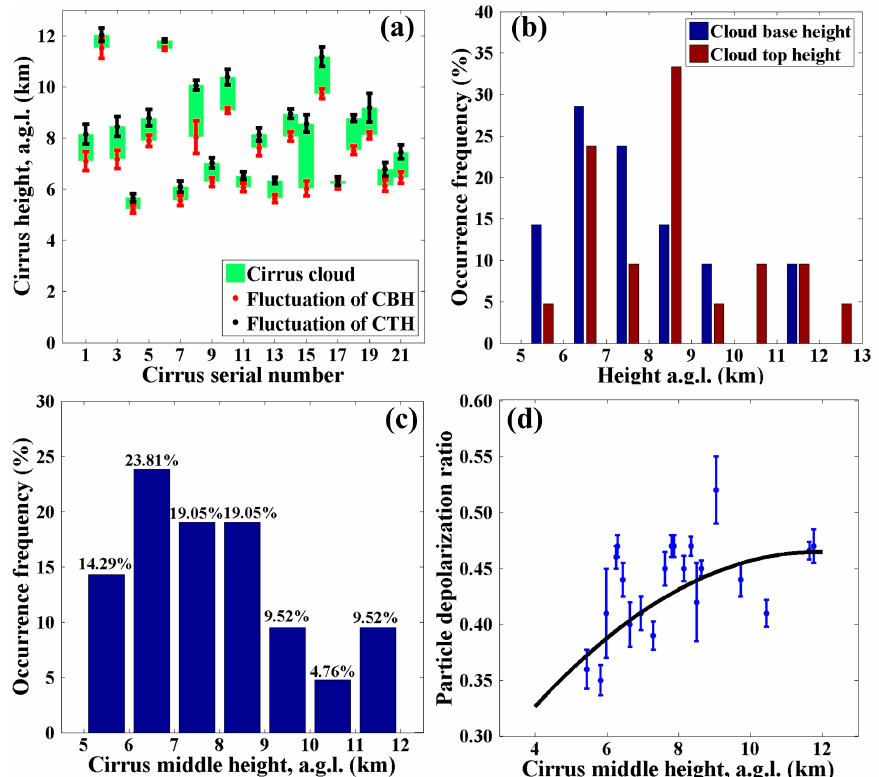
Figure 13. Measurements of cirrus clouds during TIPEX III 2014 in Naqu. ( a ) Cirrus structure and ( b ) the frequency occurrence of cloud base/top heights; ( c ) Frequency occurrence of cirrus cloud middle height and ( d ) correlation between particle depolarization ratio and cirrus middle height.